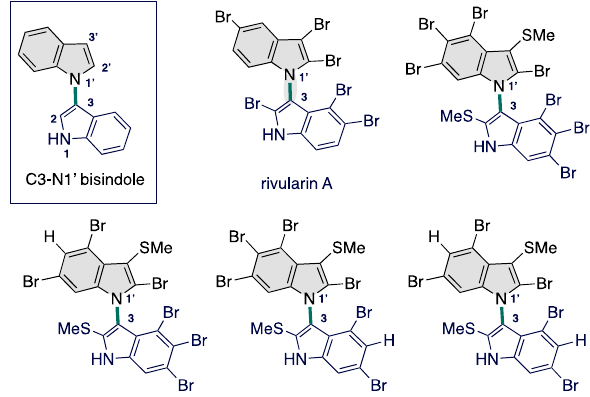
Figure 1. Structures of C3–N1 ′ bisindole alkaloids.